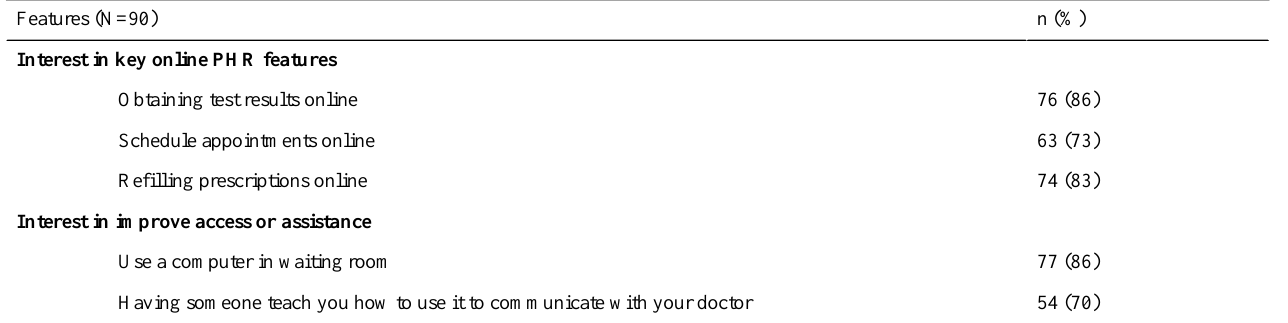
Table 3. Interest in patient portal features and